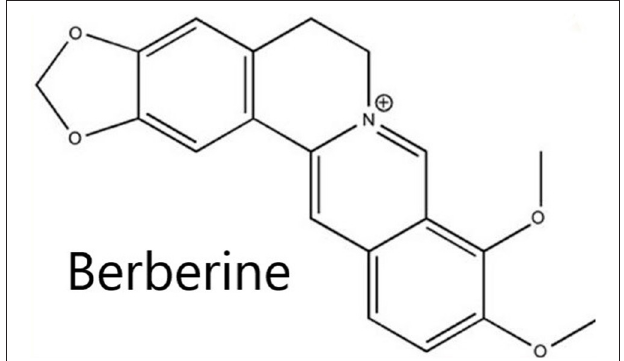
FIGURE 1 | Molecular structure of